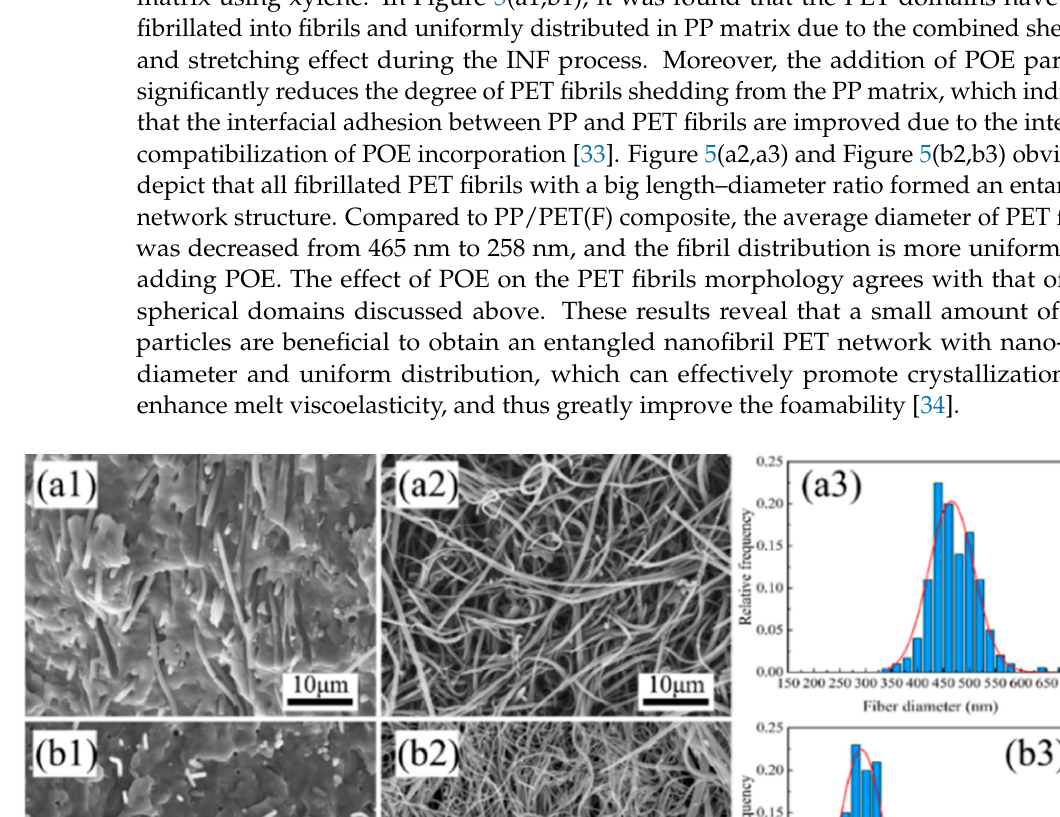
Figure 4. SEM images of the melt-blended composites cryogenic fractured surfaces: ( a ) PP/PET(S), ( b ) PP/PET/POE(S).